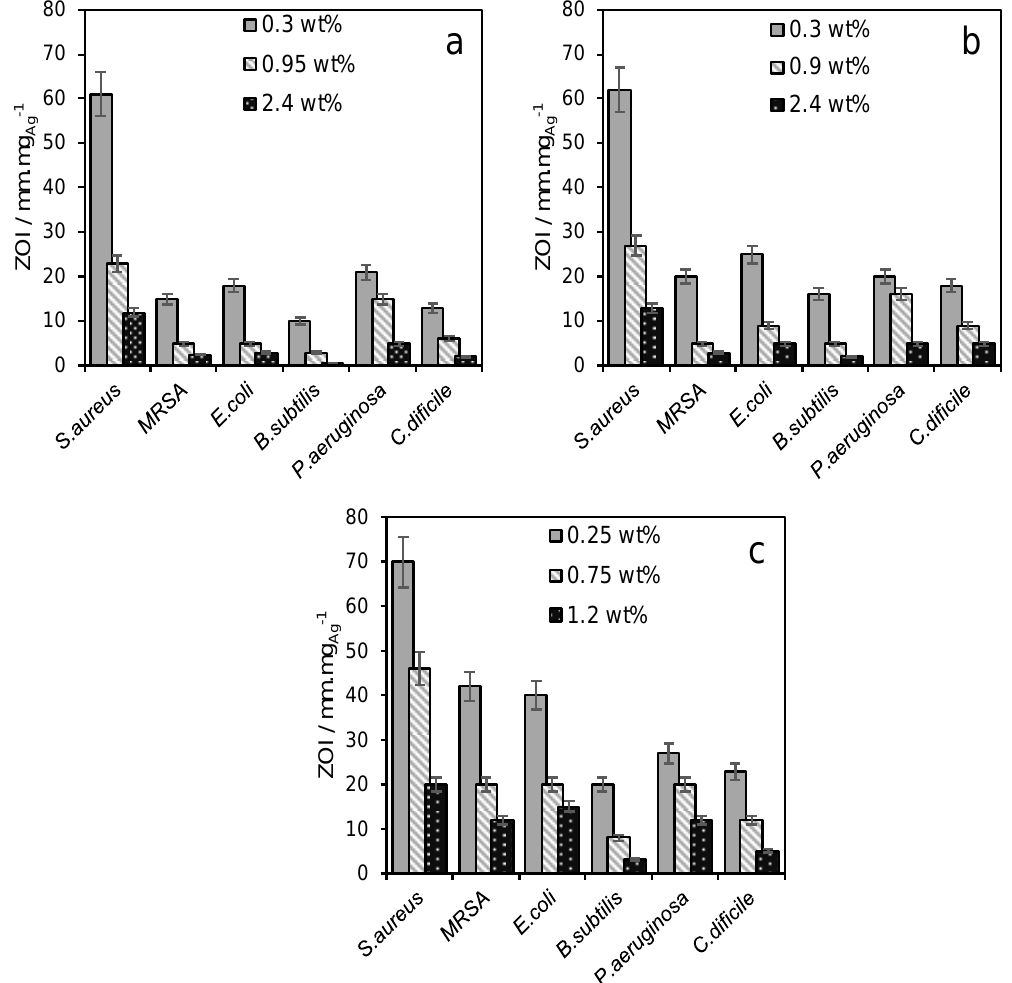
Figure 6. Zone of inhibition plots, normalized to mass of Ag, against a range of Gram-positive and Gram-negative bacteria for ( a ) Ag/SBA-15, ( b ) Ag/TiO 2 /SBA-15 and ( c ) Ag/TiO 2 /MM-SBA-15. Antibiotics 2017 , 6 , x